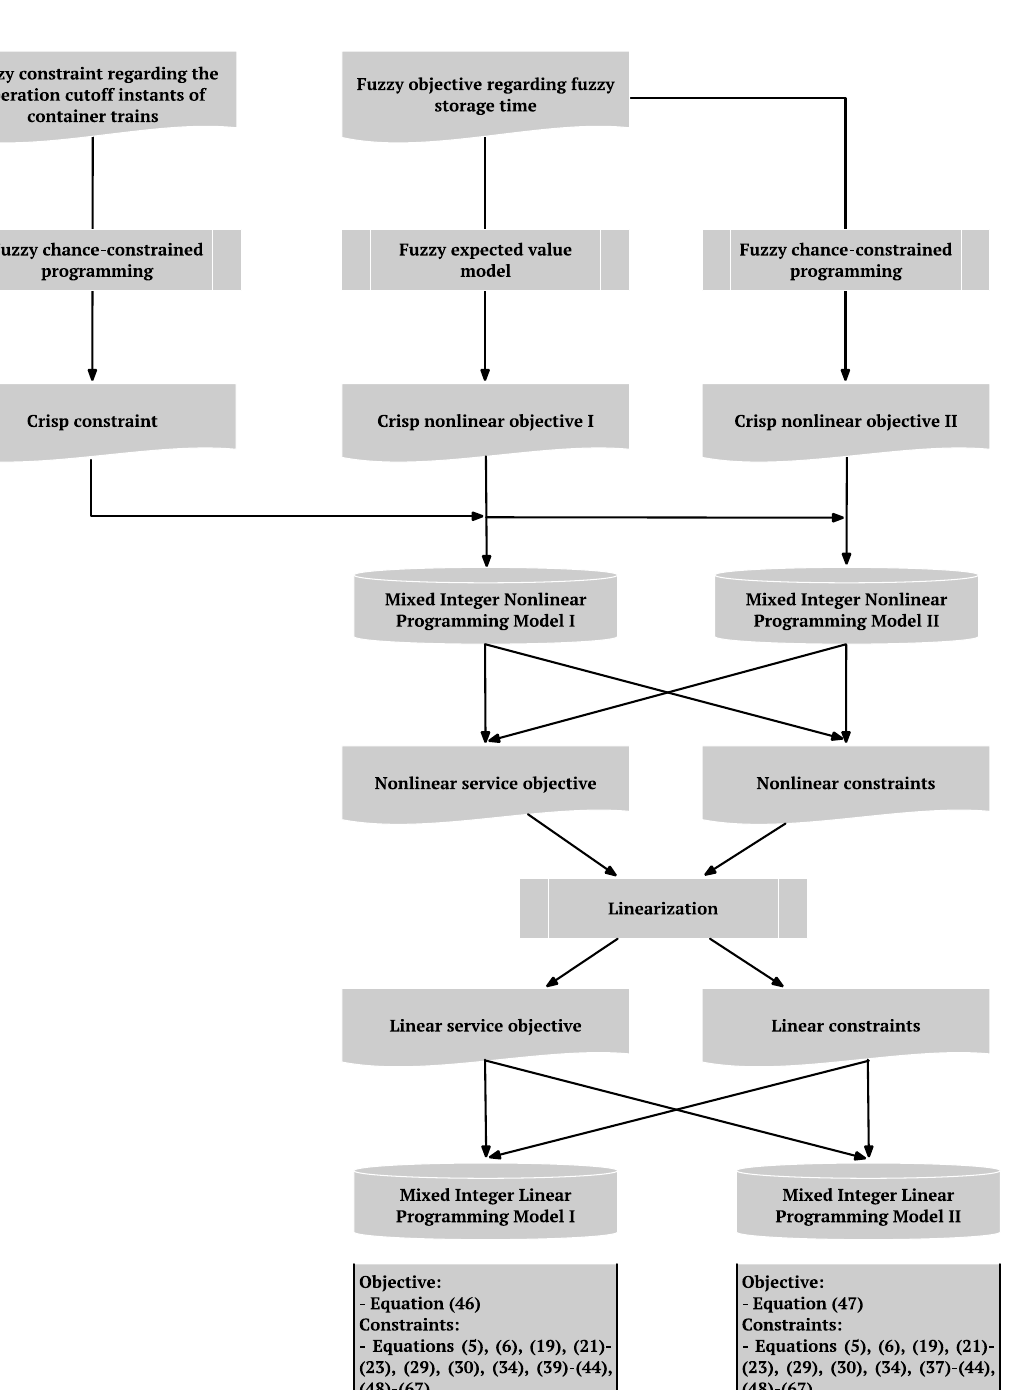
Figure 11. Solution approaches for the road-rail intermodal routing problem.